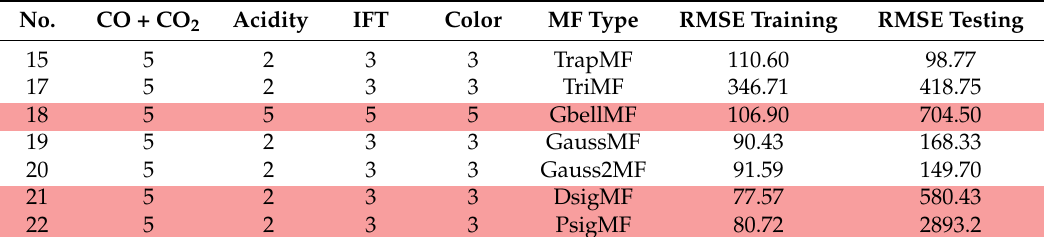
Table 10. Various combinations of MF types.